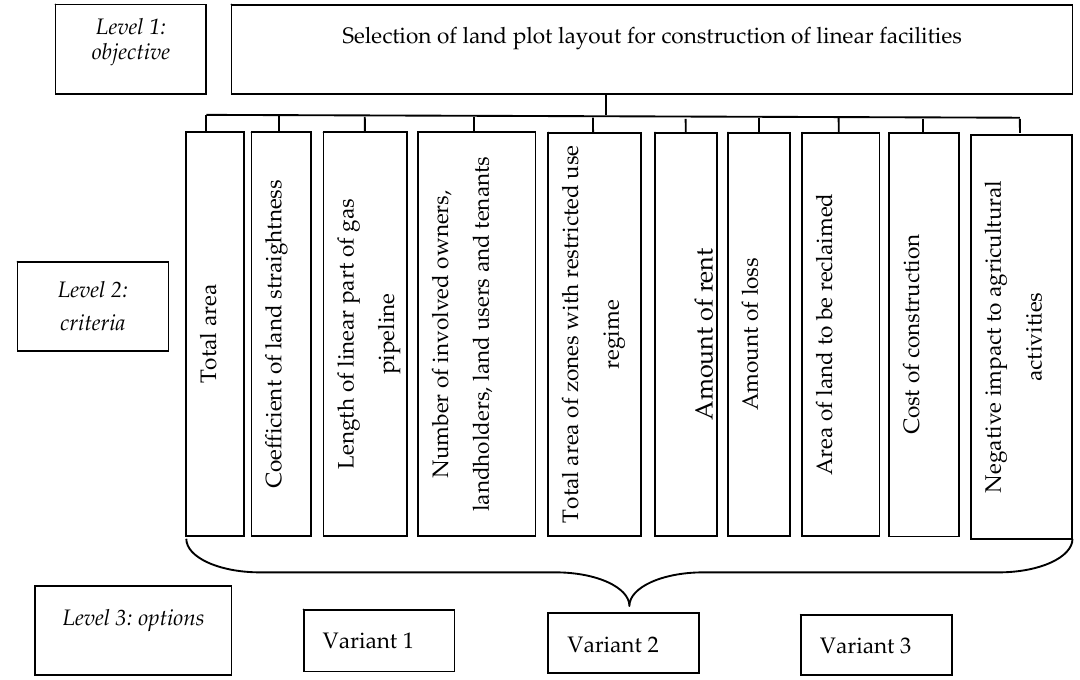
Figure 1. Hierarchical structure of project selection to locate a linear facility.